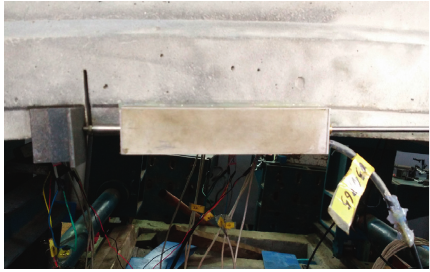
Figure 6: Measuring CMOD of the segment with displacement meter.